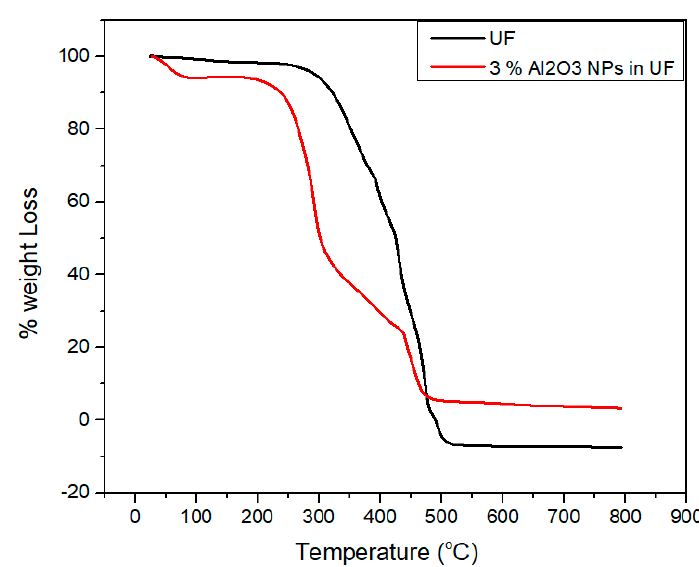
Figure 10. Thermo-gravimetric analysis of urea-formaldehyde resin with and without alumina nanoparticles.